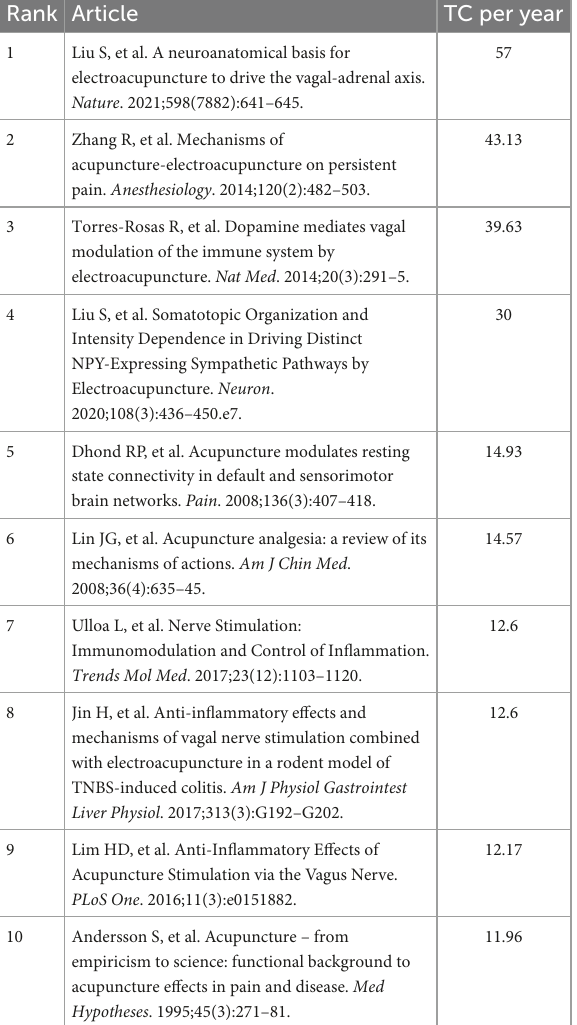
TABLE 2 10 most influential articles based on total citations per year from 100 top-cited articles.